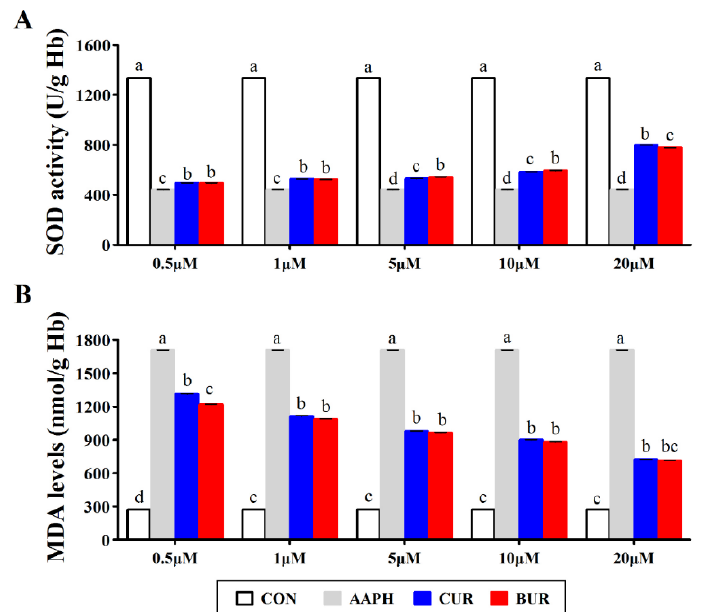
Figure 2. E ff ects of curcumin and bisdemethoxycurcumin on ( A ) the superoxide dismutase (SOD) activities and ( B ) malondialdehyde (MDA) levels in AAPH-treated erythrocytes (Experiment 1). Results are expressed as the mean ± SEM. Columns labeled with di ff erent letters are significantly di ff erent ( p < 0.05). CON group, the normal chicken erythrocytes; AAPH group, the chicken erythrocytes incubated with AAPH; CUR, the chicken erythrocytes pre-incubated with curcumin and followed by AAPH treatment; BUR group, the chicken erythrocytes pre-incubated with bisdemethoxycurcumin and followed by AAPH treatment.